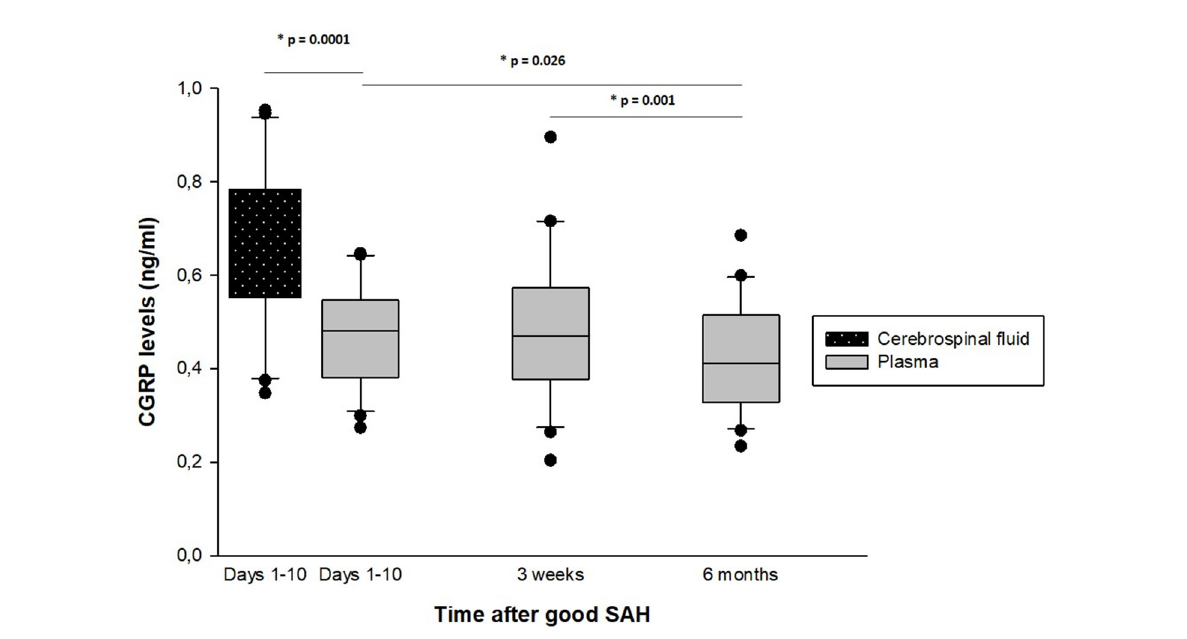
FIGURE2 Temporal dynamics of CGRP levels in serum and cerebrospinal fluid after good-grade spontaneous subarachnoid hemorrhage. The time interval (1–10 days, 3 weeks, and 6 months) after good-grade spontaneous subarachnoid hemorrhage, plotted vs. the mean endogenous calcitonin gene-related peptide (CGRP) concentrations in serum. During the first 10 days, the mean CGRP levels were significantly lower in serum than in the cerebrospinal fluid (16). At 6 months, the mean serum CGRP value was significantly lower compared to the first 10 days and compared to 3